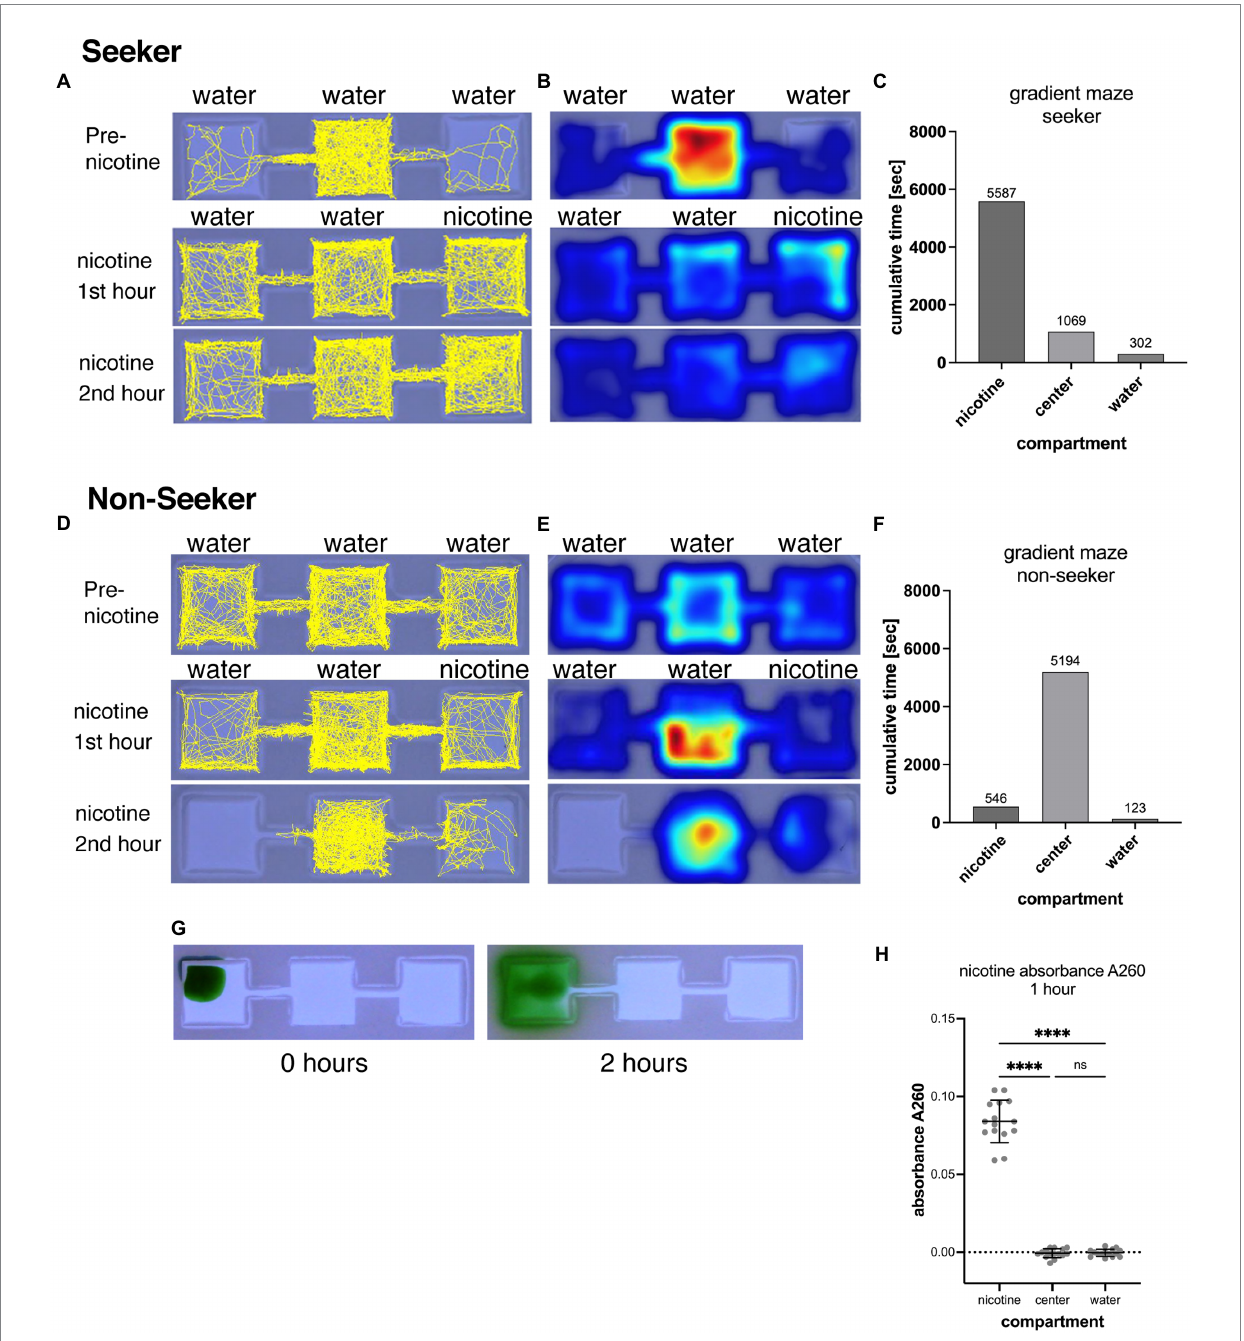
(E) for the non-seeker. Warmer colors in heatmaps indicate more time spent in a location. Examples of the analysis for a single larval zebrafish are shown in (C) for the seeker and in (F) for the non-seeker. (G) Shows the diffusion of 5 μ l green food dye added to the left outer compartment of a gradient maze. After 2 h the dye is mostly contained in the left compartment. (H) Absorbance measurements (at 260 nm) of water samples (25 μ l) taken from the nicotine, center and water compartments of 15 gradient mazes 1 h after pipetting 5 μ l of 200 mM nicotine solution into the nicotine compartments. Each data point represents one measurement from one compartment. Absorbance could be detected in nicotine compartments but not in center and water compartment. Nicotine compartment: mean absorbance 0.084 (SD = 0.0137; n = 15); Center compartment: mean absorbance − 0.0007 (SD = 0.002895; n = 15); Water compartments: mean absorbance − 0.0004 (SD = 0.002324; n = 15). **** p < 0.0001; ns >